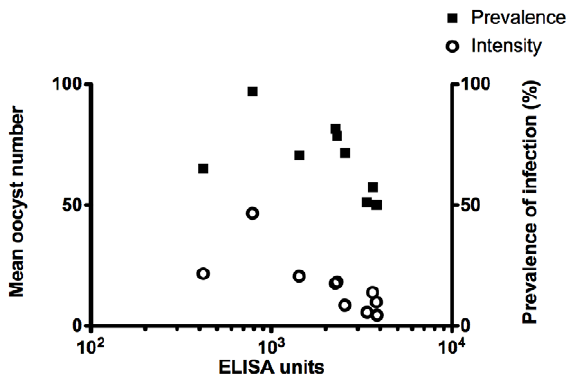
Figure 6. Total IgG antibody titer correlates with oocyst number. BALB/c mice (n=10) were immunized with Ad-MVA Pfs25 and infected with Pfs25DR3 as previously (figures 4 & 5). Mean oocyst number (circles) and the prevalence of infection (squares) were calculated per mouse as shown in figures 4a and 5a. These data are shown plotted against specific anti-Pfs25 total IgG titer for each mouse.